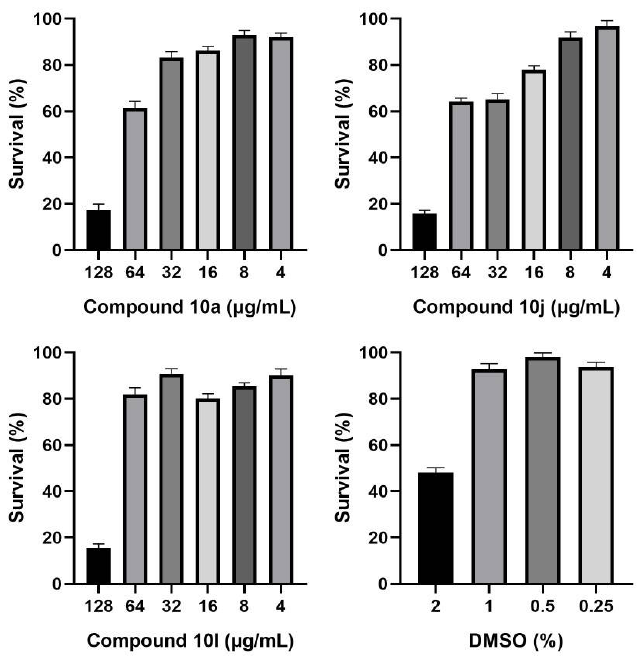
Figure 4. Cytotoxicity of compound 10a , 10j and 10l against HUVEC cells. The cell survival (%) was measured by CCK8 assay.